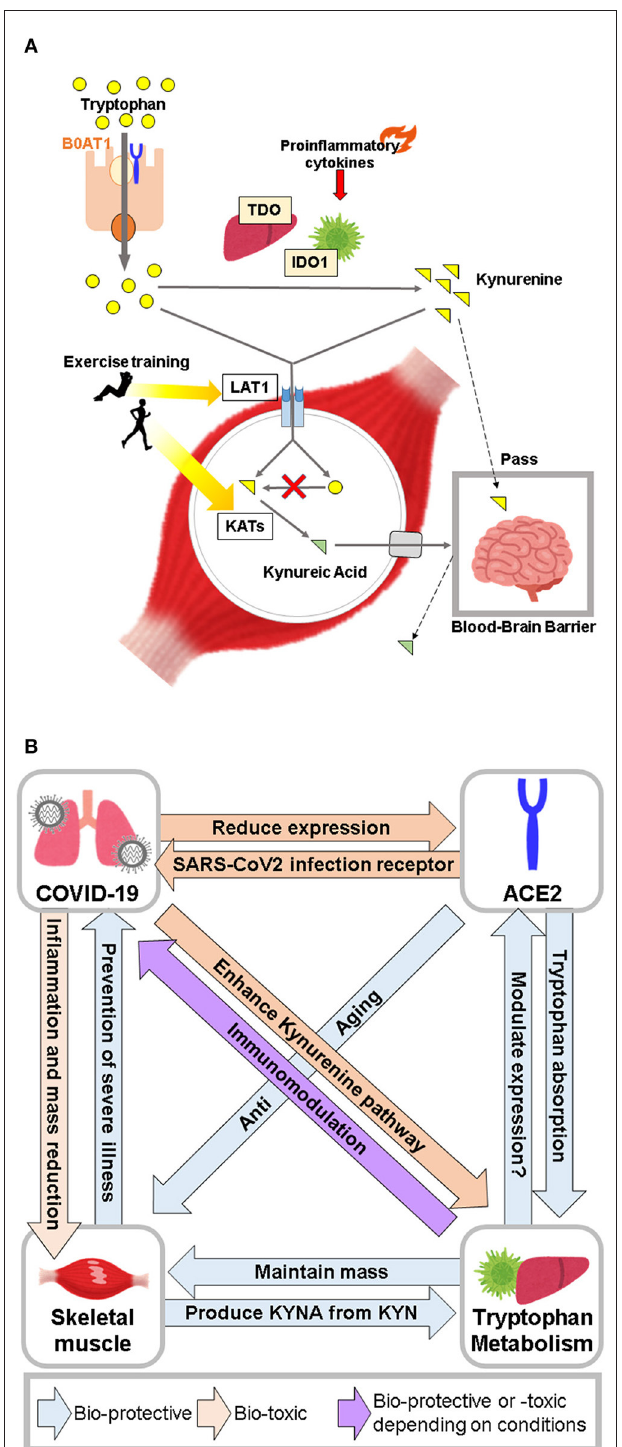
FIGURE 2 | (A) Major role of skeletal muscle in tryptophan metabolism. Skeletal muscle takes up tryptophan and kynurenine, but does not metabolize kynurenine from tryptophan due to the absence of TDO and IDO. Skeletal muscle plays a neuroprotective role by converting kynurenine to kynurenic acid. (B) Conceptual diagram of the relationship between COVID-19, ACE2, tryptophan metabolism, and skeletal